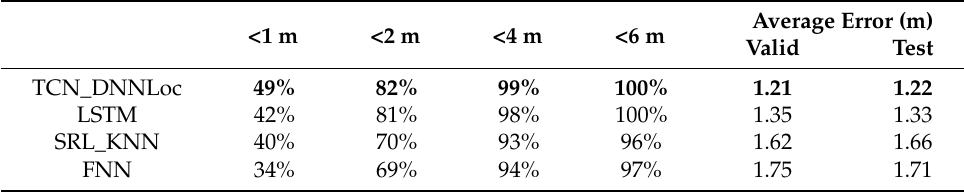
Table 7. The proportion of the average error distance of different